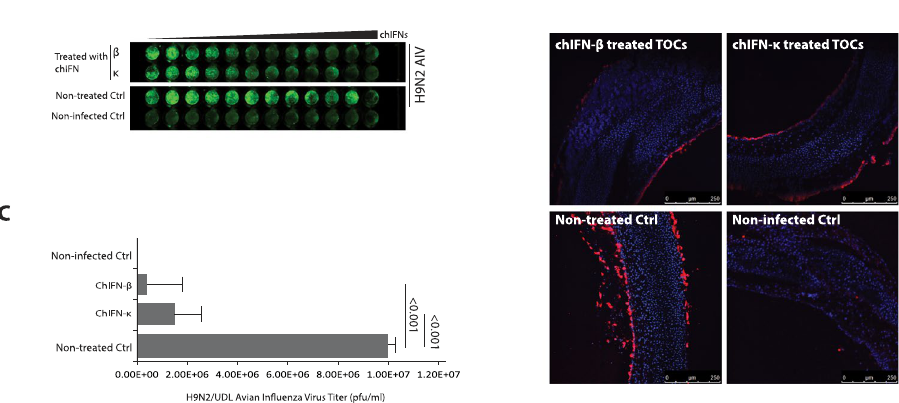
Figure 4. The chIFN- κ mediates an antiviral state in vitro and ex vivo . ( A ) CEF cells stimulated with increasing concentrations of chIFN- κ , chIFN- β (expressed in heterologous HEK-293) or media only (non-treated Ctrl), were infected with AIV (H9N2/UDL/08) or were left uninfected (non-infected Ctrl). Immunostaining of the NP protein of AIV correlates the virus replication in infected cells and antiviral activities of chIFN- κ and chIFN- β . ( B ) TOCs were stimulated for antiviral response with 1000 Units of chIFN- κ and chIFN- β before infection with AIV (H9N2/UDL/08). Immunostaining of the NP protein of influenza virus indicate the cellular replication levels of influenza viruses in IFNs treated TOCs compared to non-infected and non-treated controls. ( C ) Quantitative measurement of AIV ((H9N2/UDL/08) in TOCs supernatants. The data represents 2 or 3 independent